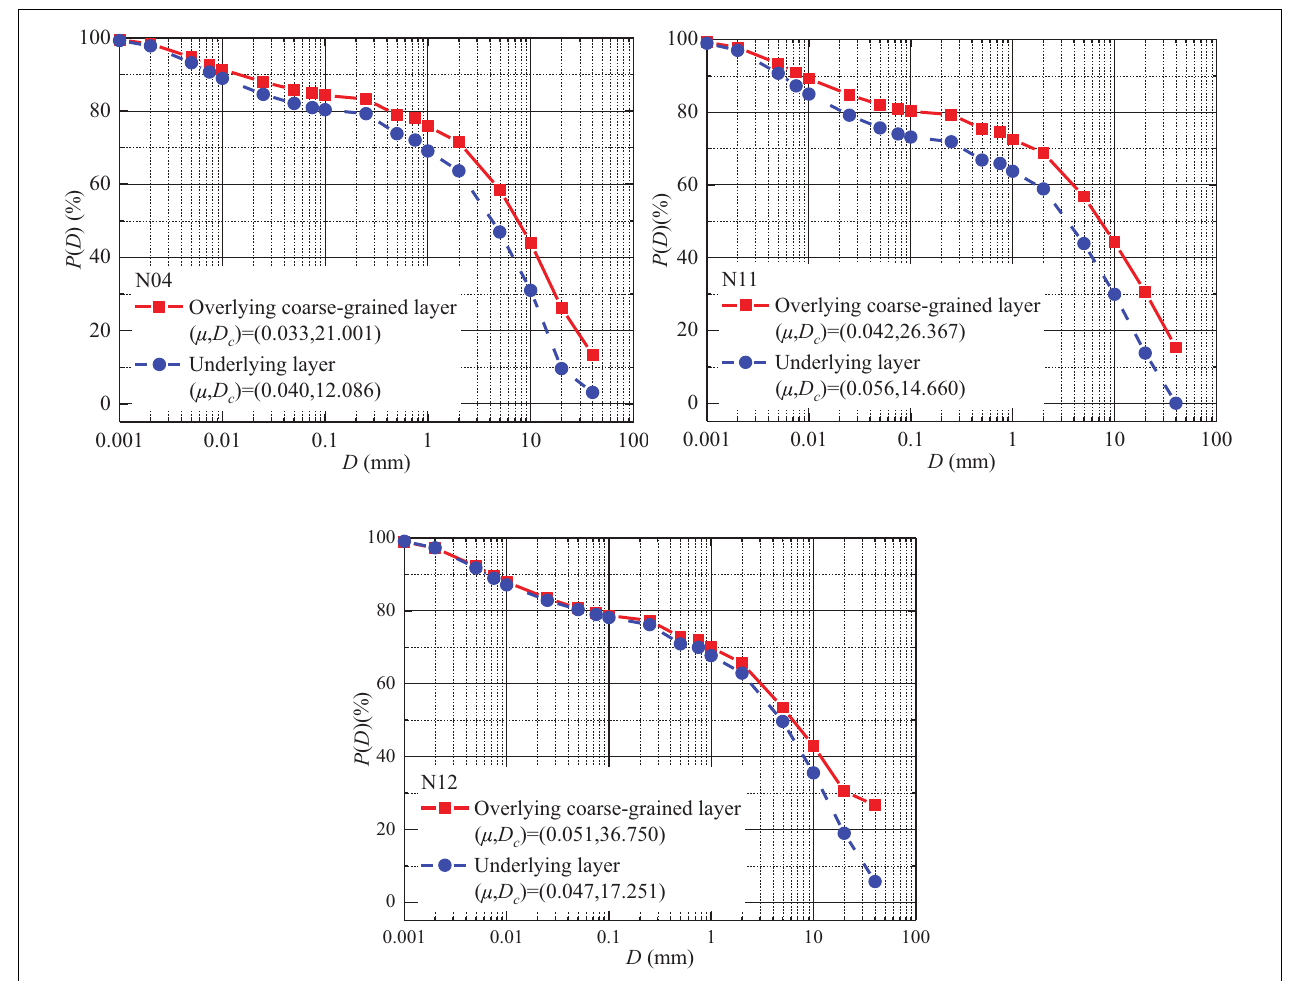
FIGURE 4 | Grain size distribution curves of overlying coarse-grained layer and underlying fluid in